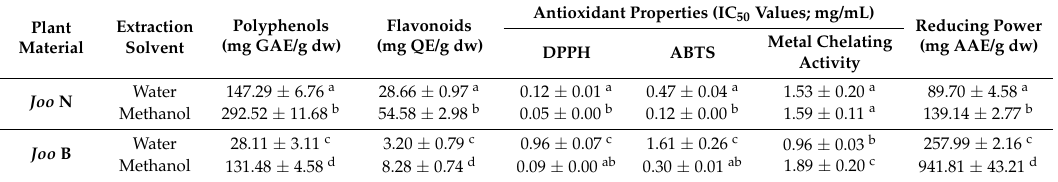
Table 3. Total phenolic content, flavonoid content and antioxidant activities in aqueous and methanolic extracts of needles and berries of Juniperus oxycedrus subsp. oxycedrus